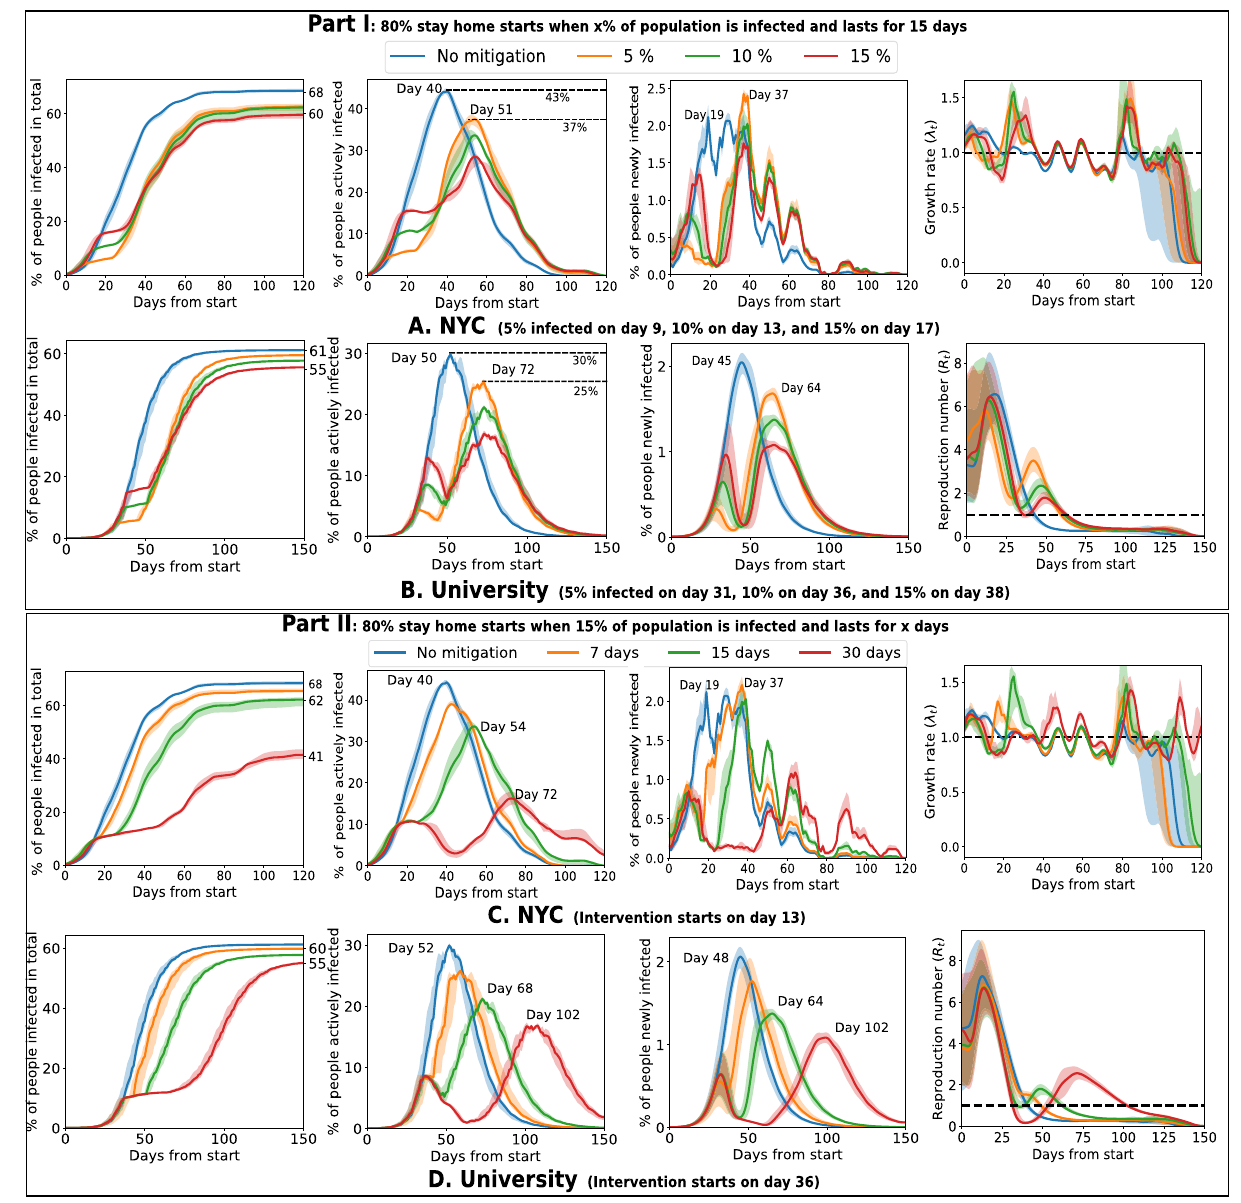
Figure 2. Uniform lockdown for limited duration delays and lowers the peak of the infections, but often has a small effect on total infection. Here, 80% check-in or meeting events are randomly removed. Part I: A limited duration intervention (15 days) delays (by 11 days in NYC and 22 days in the University) and lowers (by 6% in Foursquare NYC and 5% in the University) the peak of active cases, but does not reduce the total number of infected people, as the second peak is imminent. Part II: With the increasing length of intervention, the number of infected people reduces (by 33% in NYC), but in the University dataset, the effect is Part I of Fig. 2 studies the disease spread with a varied starting time of the intervention while keeping its duration fixed at 15 days. In the Foursquare NYC dataset, the intervention starts on the day 9 when 5% of the population gets infected. Compared to the scenario without intervention, this strategy reduces the total number of infected agents by 8% , delays the peak of active infections by 11 days, and lowers it by 6% . The peak of new infections is also delayed by 18 days. The University dataset shows a similar pattern, as the peaks in active and new infection are delayed by 22 and 19 days respectively. Other datasets show trends consistent with the above (Supplementary Fig. S3 online). We note that an earlier lockdown is not necessarily the better strategy when implemented for a fixed duration. An imperfect lockdown can allow the infection to survive, which then spreads rapidly on the removal of the intervention and produces a high eventual peak or second wave. On the other hand, a lockdown implemented somewhat later achieves a lower peak later on, and a lower total number of infections.